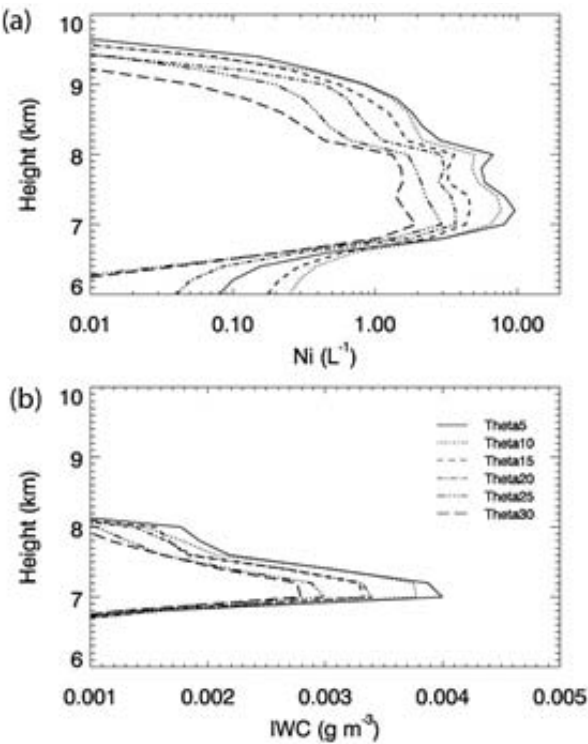
Fig. 7. Horizontal domain and time averaged (a) vertical profiles of N i and (b) IWC simulated in the CRM under different onset sin- gle contact angle. Increase in the contact angles (shown as ThetaX, where X is contact angle in degrees) results in the decrease of N i and IWC. Fig. 8. Time series of vertical profile of cloud N i (horizontal domain-average) simulated using CRM. The total cloud evolution time simulated was ∼ 8h. Each panel shows the cloud structure un- der different onset single contact angle (shown as ThetaX, where X is contact angle in degrees). The N 0 was 10.7L − 1 in each case. The cloud structure and initiation time are sensitive to the contact angles. The color bar shows N i.